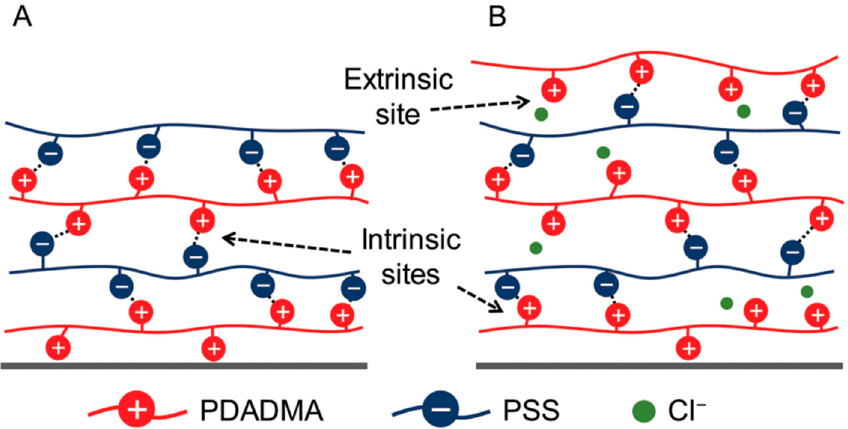
Figure 6. ( A ) PSS / PDADMAC multilayers containing only polyion-polyion interactions (i.e., intrinsic charge compensation) and ( B ) the same multilayers but overcharged or overcompensated; also containing extrinsic polyion-counter ion interactions. Figure taken from reference [130], copyright © 2020 Royal Society of Chemistry.